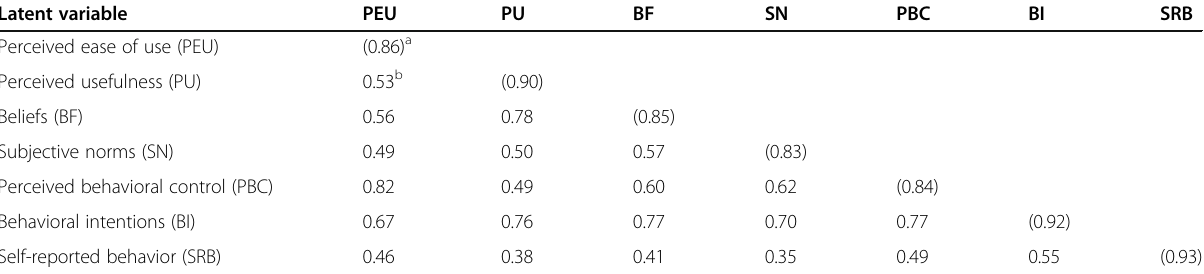
Table 4 Discriminant validity of the measurement model Latent variable